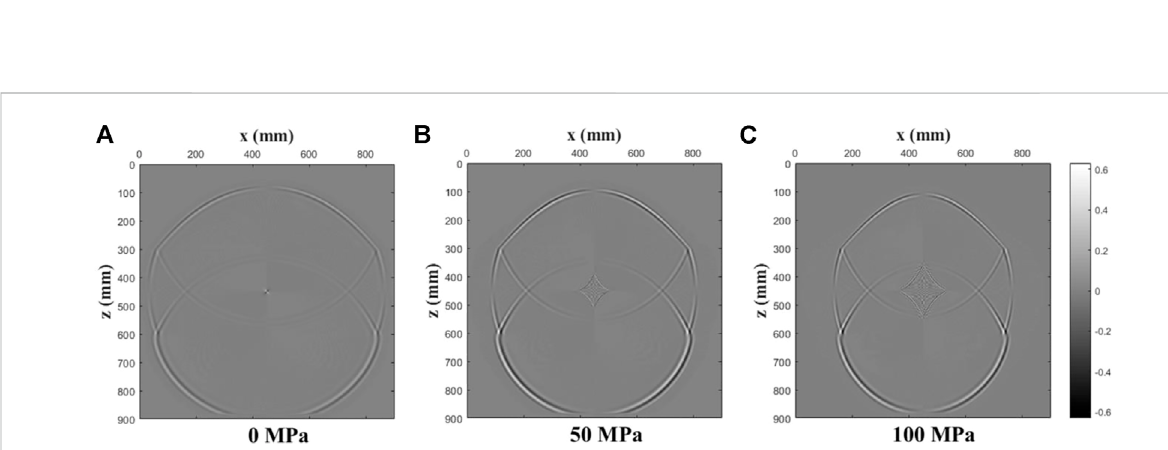
Frontiers in Earth